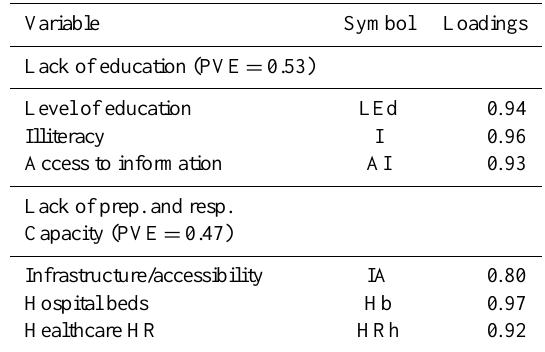
Table 5. Results of the principal component analysis resilience in-